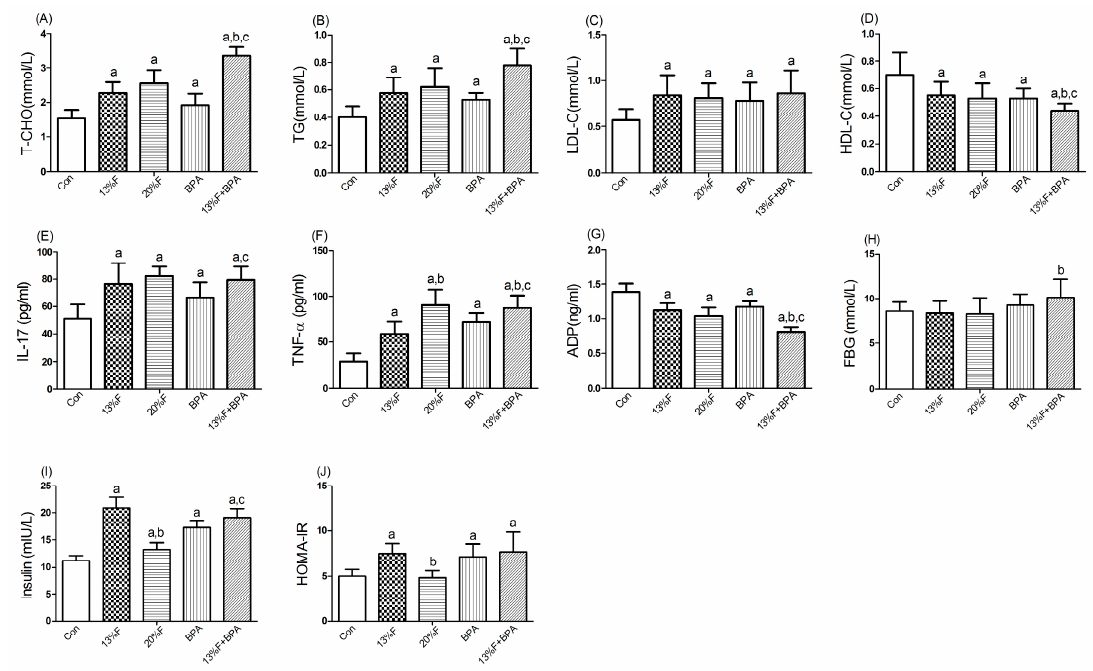
Figure 2. E ff ects of fructose and / or BPA exposure on lipid profile, inflammatory cytokines and ADP. Serum levels of ( A ) T-CHO; ( B ) TG; ( C ) LDL-C; ( D ) HDL-C; ( E ) IL-17; ( F ) TNF- α ; ( G ) ADP; ( H ) FBG; ( I ) insulin; ( J ) HOMA-IR of male rats after eight weeks of treatment with fructose and BPA. Values are expressed as means ± SD, n = 10. Di ff erences between groups were considered as significant at p < 0.05 and were analyzed with one-way ANOVA. a di ff erent compared to Con; b di ff erent compared to 13% F; c di ff erent compared to BPA ( p < 0.05). Con, control group; F, fructose group; BPA, 1 µ g / mL BPA group.